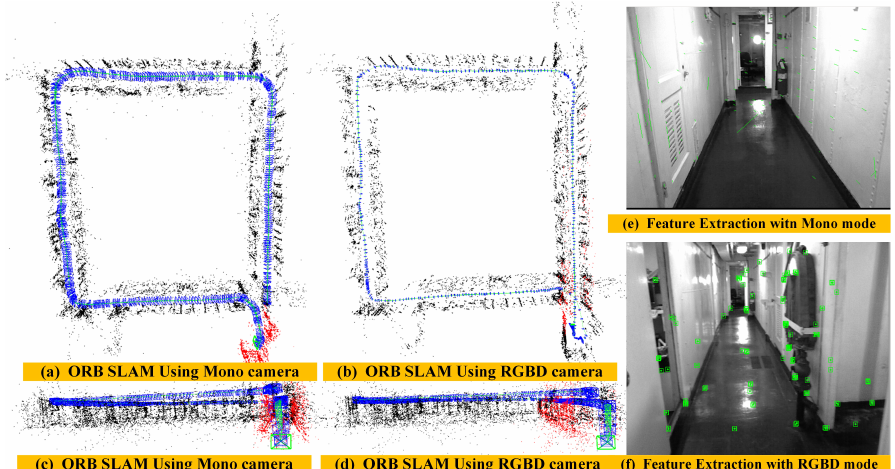
Figure 12. The performance of mapping results after applying the ORB-SLAM algorithm using the mono and RGB-D camera,